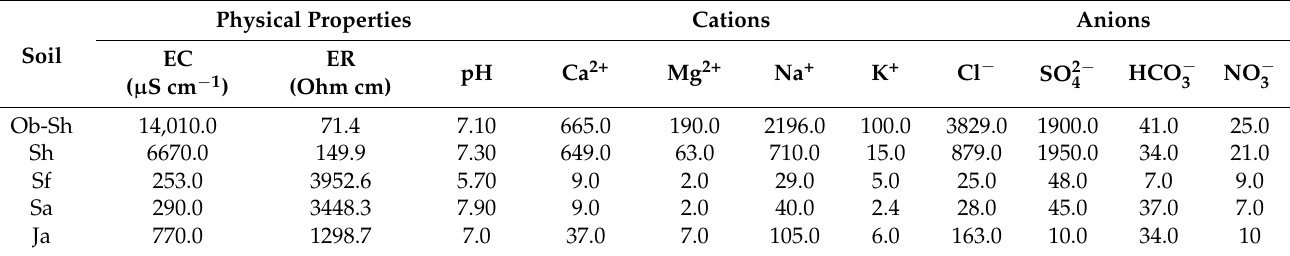
Table 2. Chemical analysis of soil extracted solutions (mg/L).